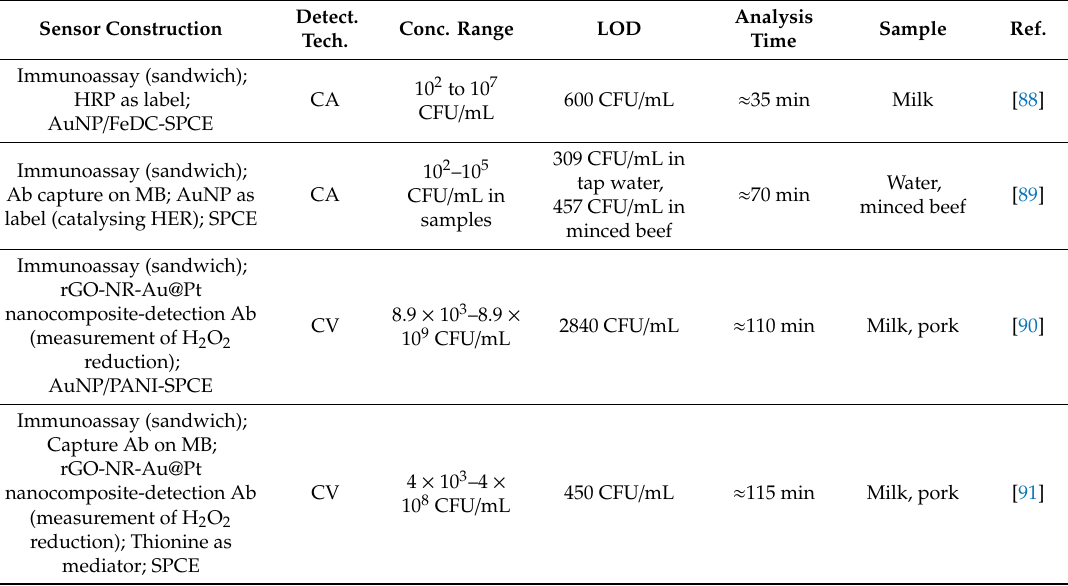
Table 3. SPE-based sensors for E. coli O157:H7 detection in